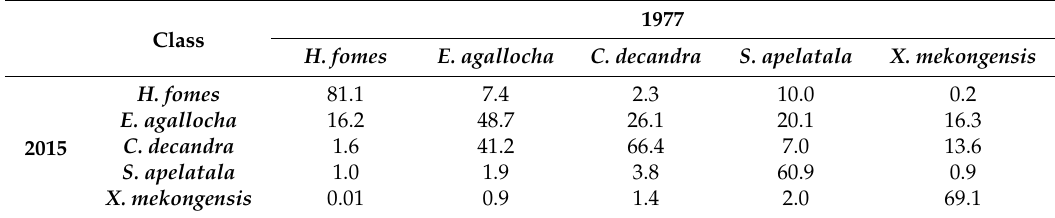
Table 4. Mangrove cover change matrix of the Sundarbans between 1977 and 2015 (percentage).